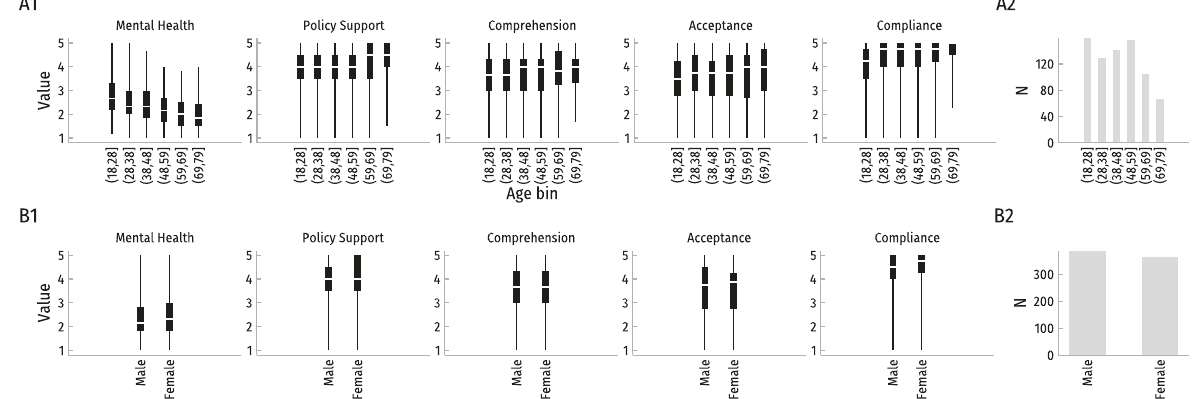
Fig. 2 Descriptive information. Mental health in the last month before the study, support for pandemic-mitigating political measures, comprehension of the functionality of digital contact-tracing applications (DCTAs), acceptance of DCTAs, and compliance with DCTAs. ( A1 ) Age differences. ( B1 ) Gender differences. ( A2 , B2 ) Frequency distribution of age groups and gender in the sample ( n = 3 gender non-responses were excluded in B1 and